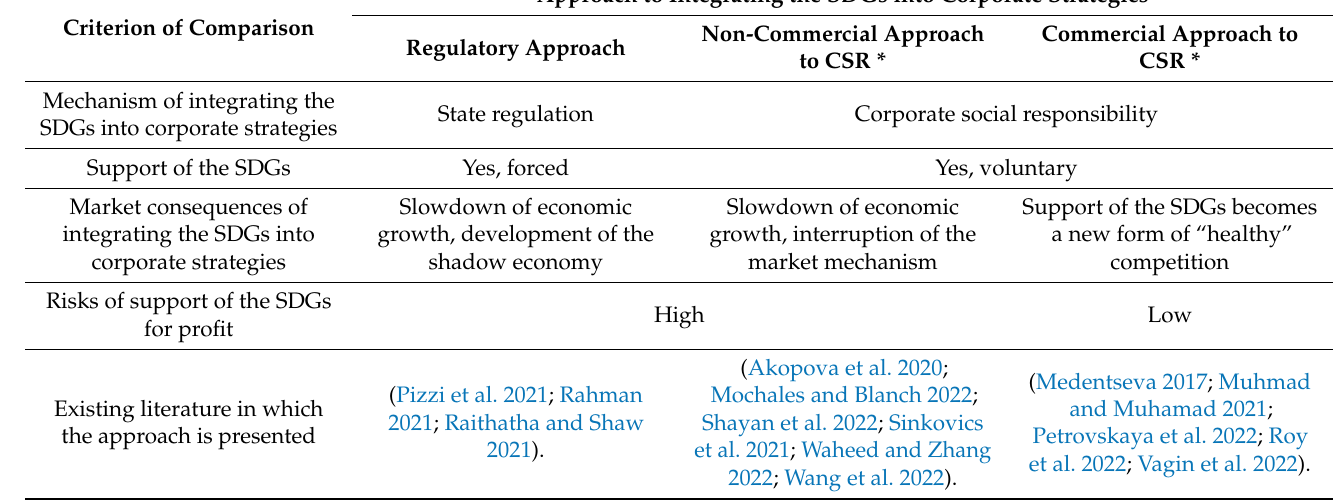
Table 1. Comparative analysis of the existing approaches to the integration of the SDGs into corporate